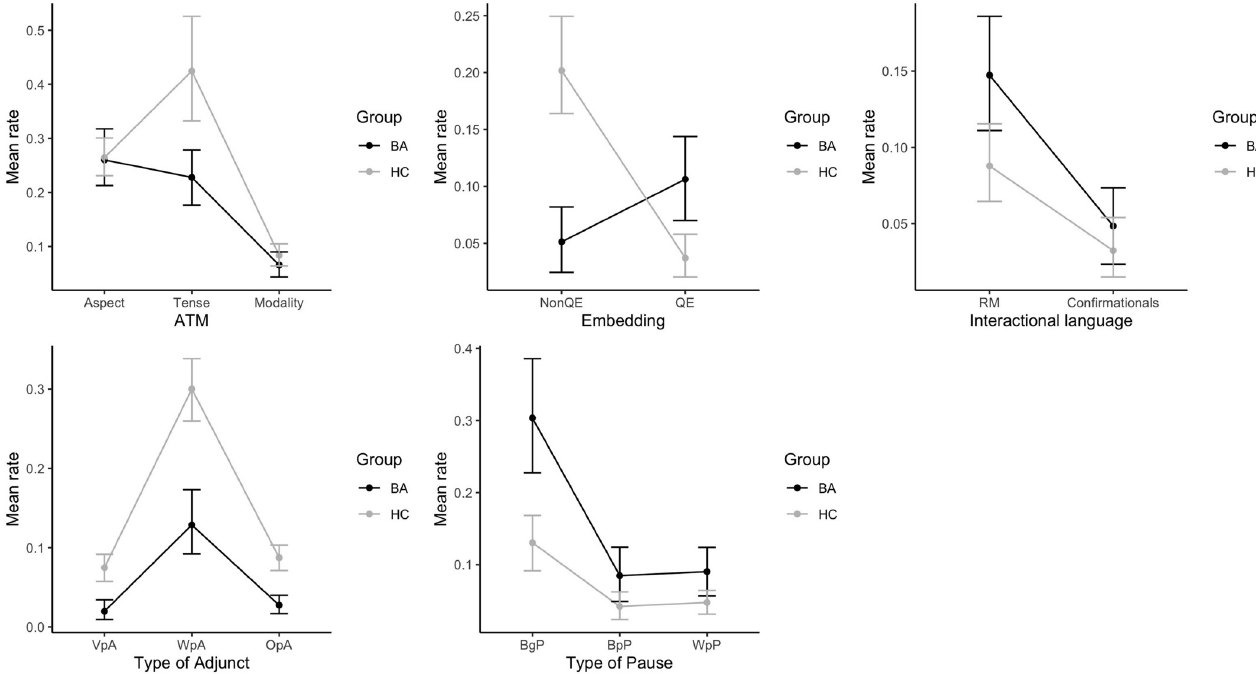
Fig 2. Mean ratios of subtype variables from different domains in both groups. Abbreviations: NonQE: Non-quotational embedding, QE: Quotational embedding, RM: Response markers, VpA: VP-attached adjunct, WpA: Within-propositional adjunct, OpA: Outside-propositional adjunct, BgP: Between g- units pauses, BpP: Between-phrase pauses, WpP: Within-phrase